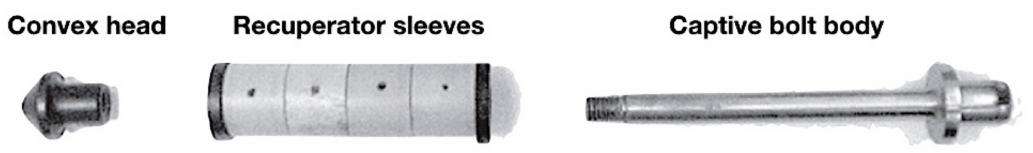
Figure 2. Bolt components of the non-penetrating captive bolt (adapted from Accles and